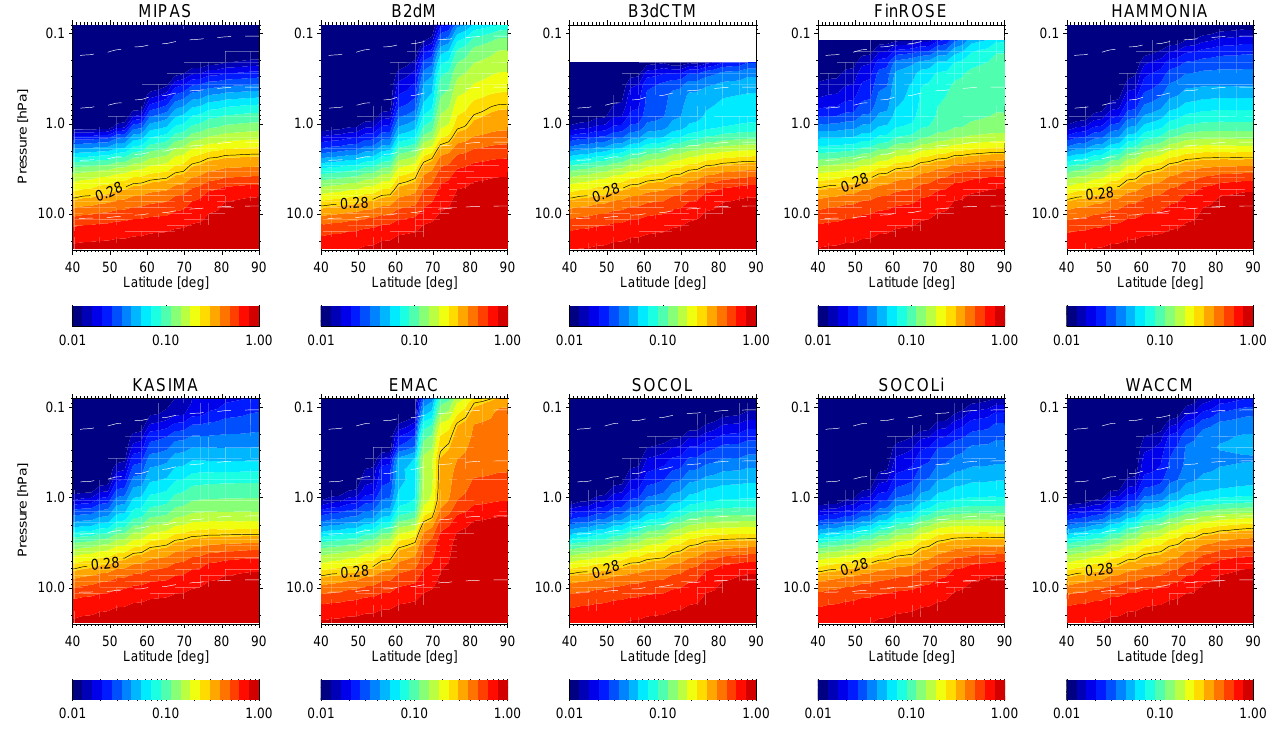
Fig. 23. Zonal mean (2N 2 O 5 +HNO 3 )/NO y ratios averaged over the period 15–30 November in MIPAS observations and model simulations. The MIPAS ratio of 0.28, encountered at altitude of the maximum of the SPE-induced NO y layer, is indicated by a black line.